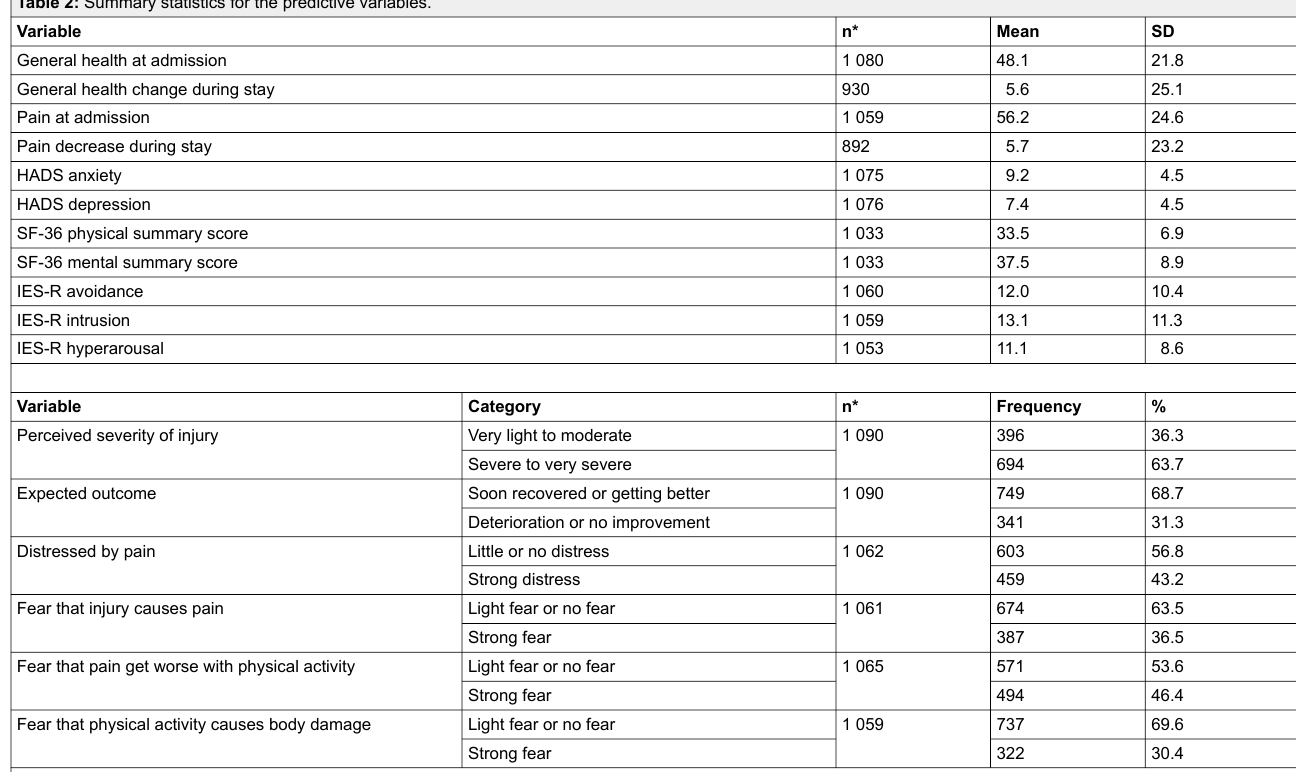
Table 2: Summary statistics for the predictive